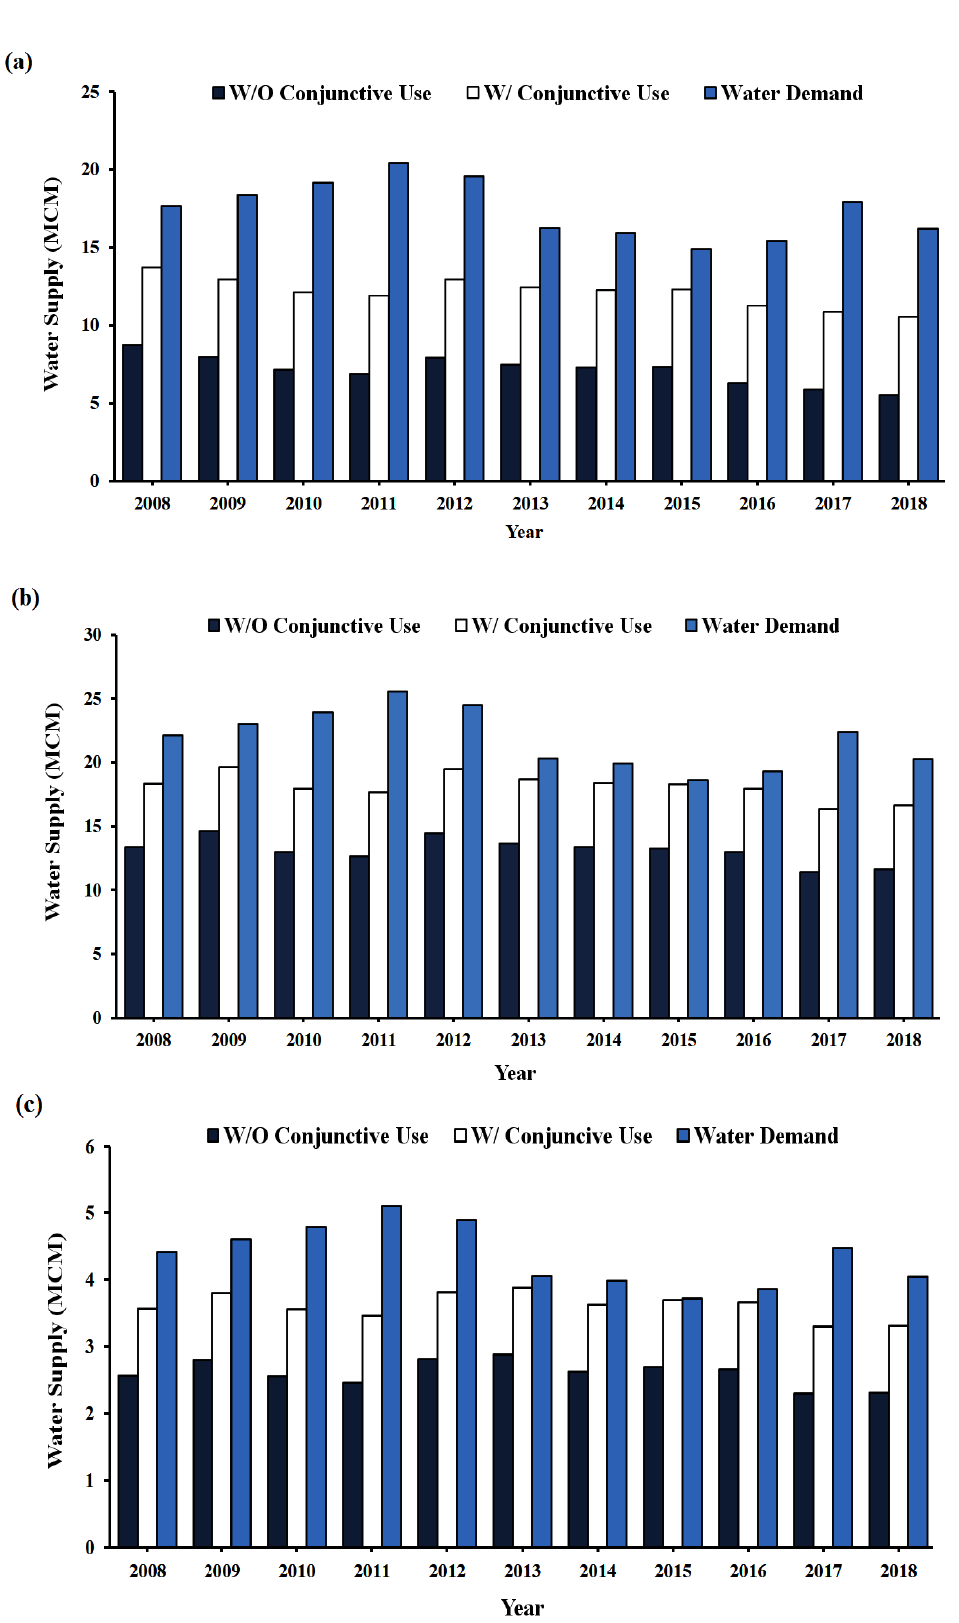
Figure 9. Water demand, total water supply, and optimized water supply in the Osan watershed for the ( a ) Osan, ( b ) Hwasong and ( c ) Pyeongtaek subareas. Table 3 summarizes the distribution total water supply and water deficit with and without conjunctive use in the Osan watershed. The water deficit is specified with respect to the water demand pertaining to the crop water requirement in each subarea, calculated using the FAO-CROPWAT model defined in Equation (1). In the Osan subarea, the total water supply ranges from 5.52–8.74 MCM with a deficit of 7.57–13.53 MCM without con- junctive use. With conjunctive use, the total water supply increased to 10.52–13.74 MCM and the deficit decreased to 2.57–8.53 MCM. In the Hwasong subarea, the total water sup- ply and deficit was 11.38–14.62 MCM and 5.36–11.01 MCM, respectively, without con- junctive use. The Hwasong subarea shows a similar pattern, as total water supply in- creased by 16.38–19.62 MCM, whereas the water deficit reduced by 1.36–7.87 MCM. In the Pyeongtaek subarea, without conjunctive use, the total water supply was 2.30–2.88 MCM and deficit was 1.03–2.65 MCM. With conjunctive use, there was an increase in the total water supply of 3.30–3.88 MCM, and the deficit decreased by 0.03–1.65 MCM. From these results, conjunctive use increases water supply and decreases deficit throughout the Osan watershed. Table 3. Distribution of surface water, groundwater, total supply, and deficit with/without conjunctive use in the Osan watershed. Subarea